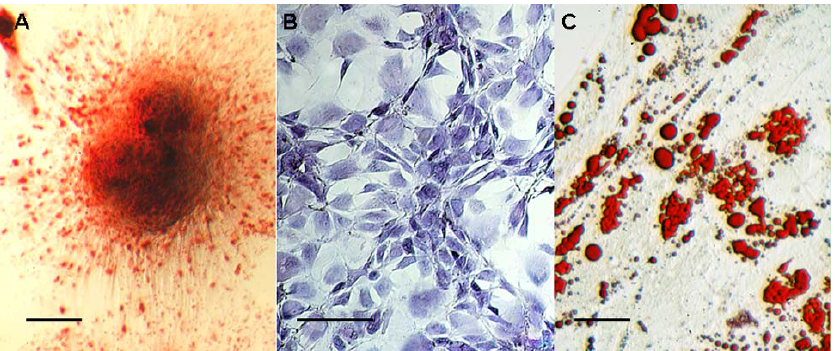
Figure 3. The hBMSC differentiation assay by alizarin red (Figure 3A), toludine blue (Figure 3B) and lipid droplets (Figure 3C) (bars indicate 100 μ